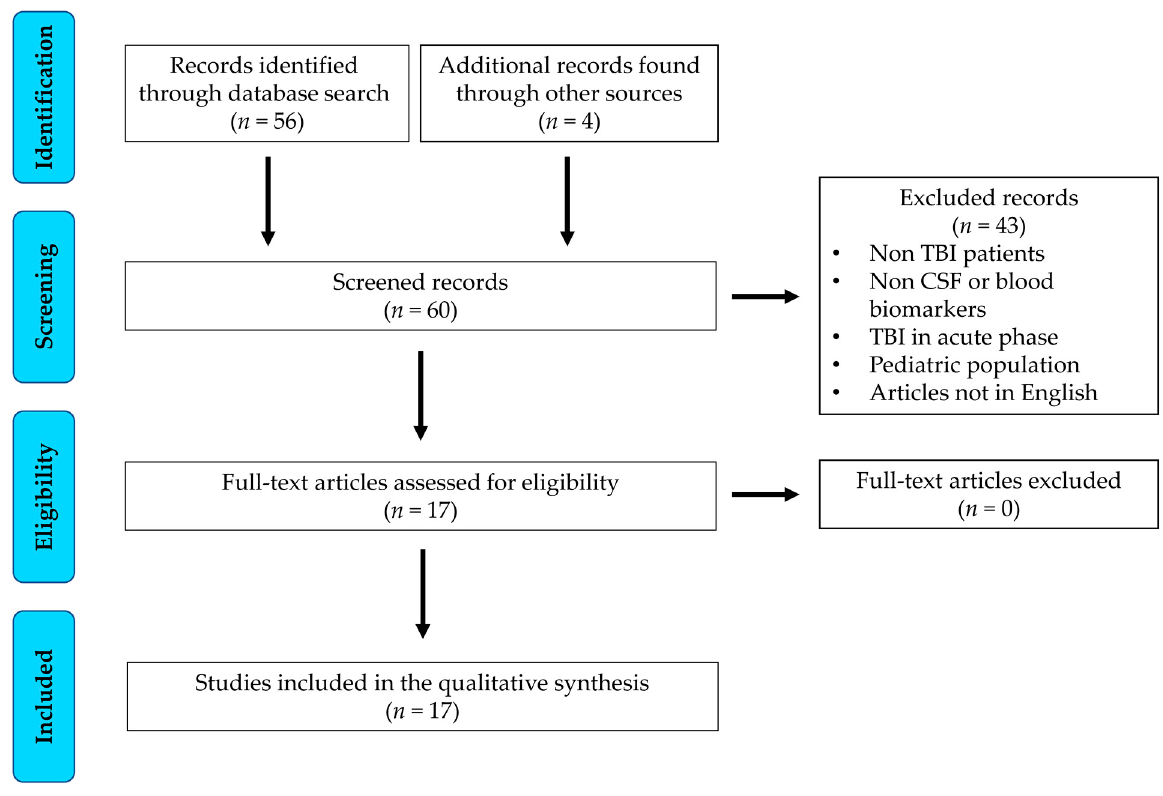
Figure 1. Flow of the scoping review.